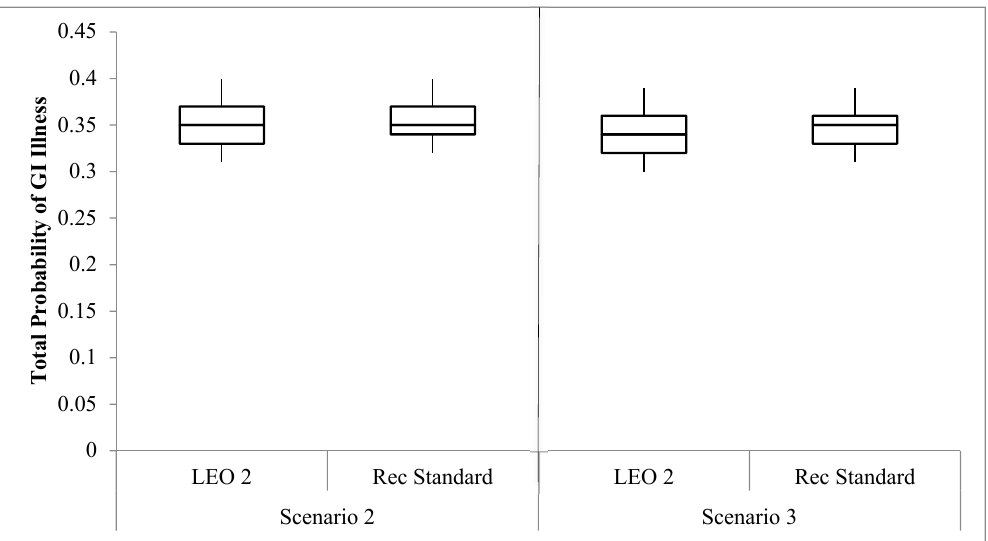
Figure 4. The calculated probabilities for a GI illness under Scenarios 2 and 3. The 5th, 25th, 75th, and 95th percentiles, as well as the median, are presented. LEO 2 had an E. coli concentration of 163 cfu 100 mL − 1 and the recreational standard had an E. coli concentration of 126 cfu 100 mL − 1 .